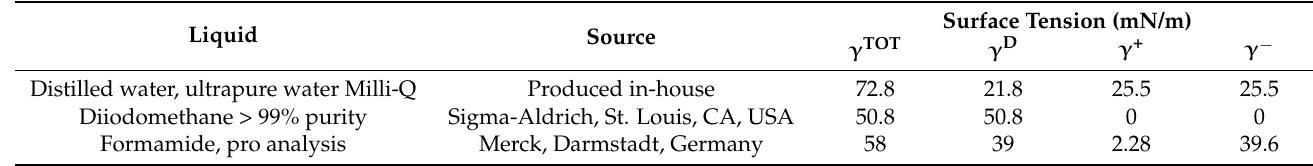
Table 1. Test liquids and their surface tension components adapted from